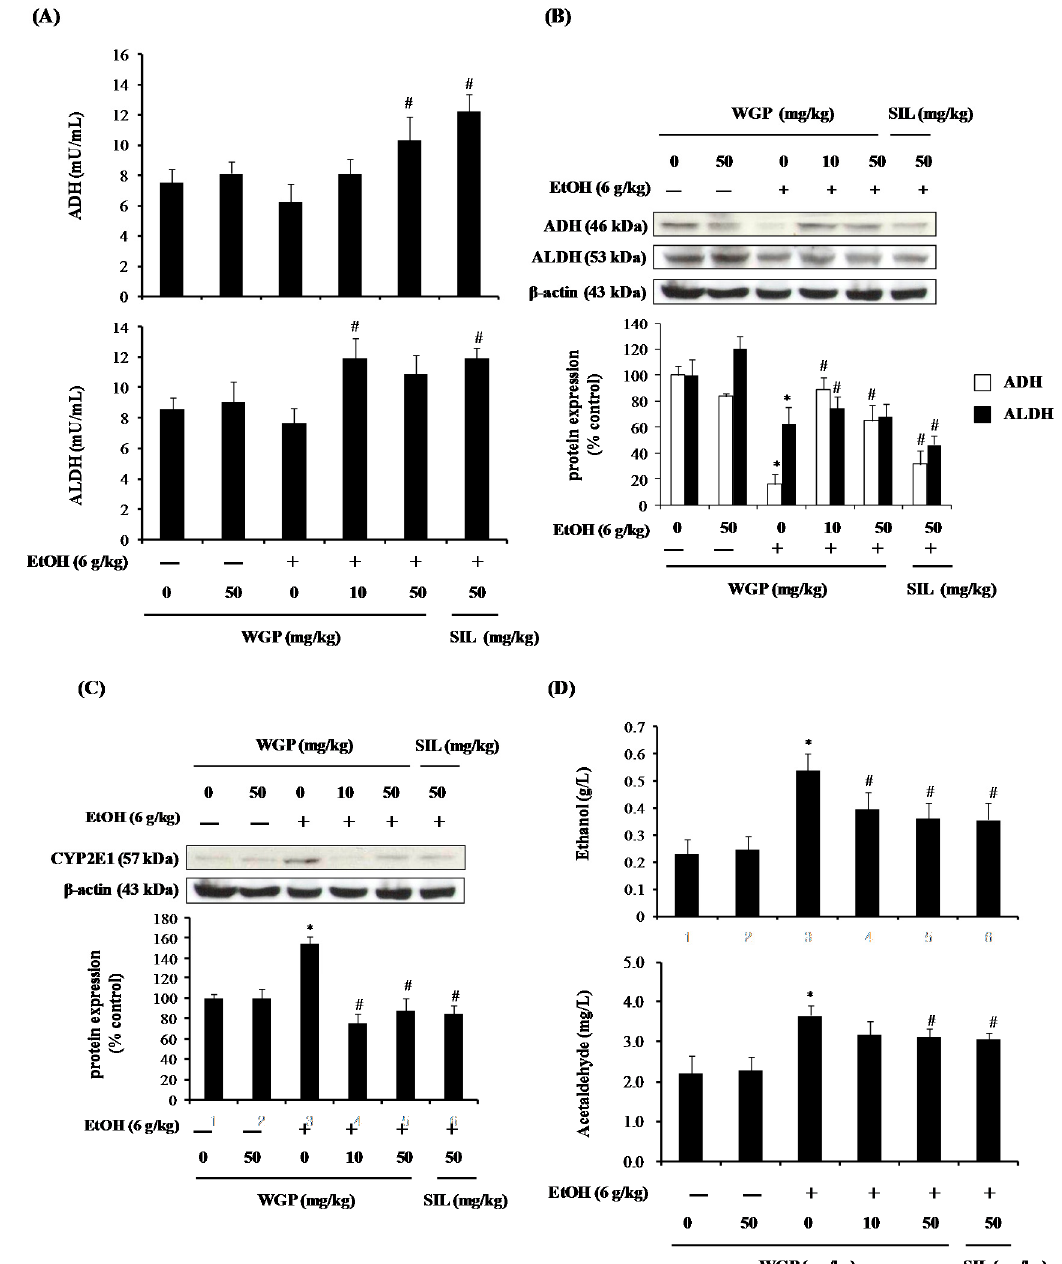
Figure 6. Effect of WGP administration on ethanol metabolism pathway in ethanol-treated SD-rats. ( A ) Serum levels of alcohol dehydrogenase (ADH) and aldehyde dehydrogenase (ALDH); ( B ) protein expressions of hepatic ADH and ALDH; ( C ) protein expression levels of hepatic CYP2E1; and ( D ) plasma levels of ethanol and acetaldehyde. Each value represents the mean ± SD for five rats. * p < 0.05 indicates differences from the unstimulated-control group; # p < 0.05 indicates differences from the ethanol-treated group.